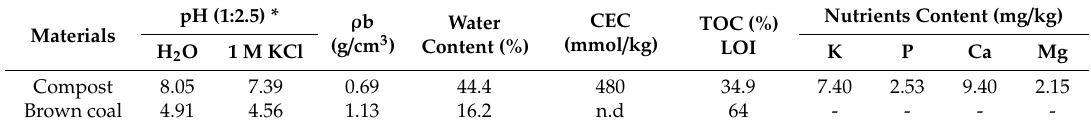
Table 1. Physico-chemical properties of studied reactive materials.